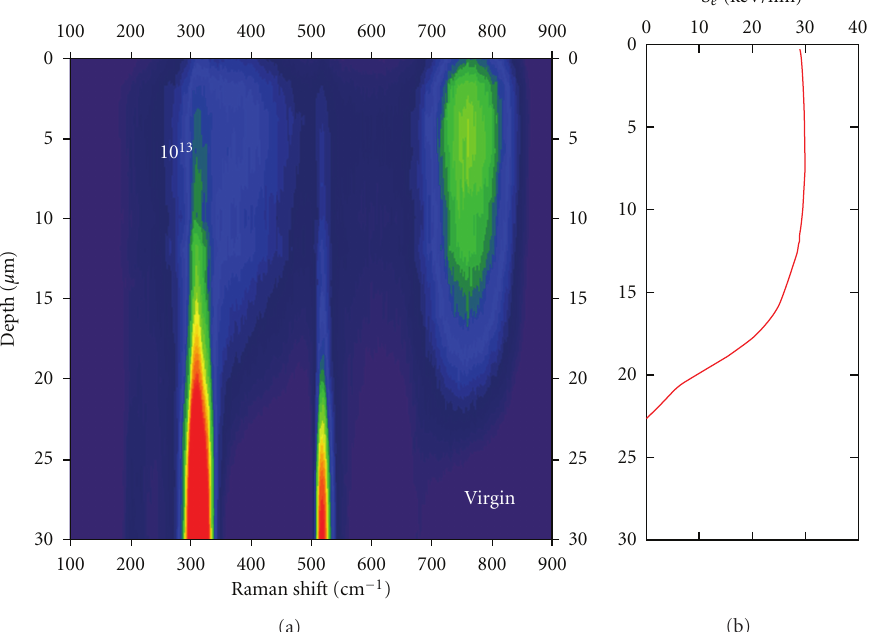
Figure 10: (a) Raman cartography made of spectra recorded at di ff erent depths on a Gd 2 Ti 2 O 7 crystal irradiated at RT with GeV Xe ions at 10 13 cm − 2 . (b) Variation with depth of the electronic energy loss ( S e ) for GeV Xe ions in Gd 2 Ti 2 O 7 .